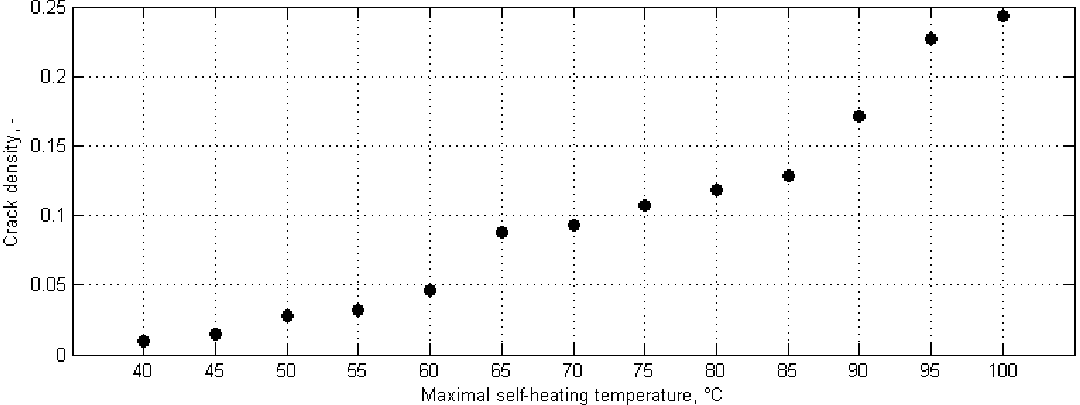
Figure 14. Crack density for various self-heating temperature values.